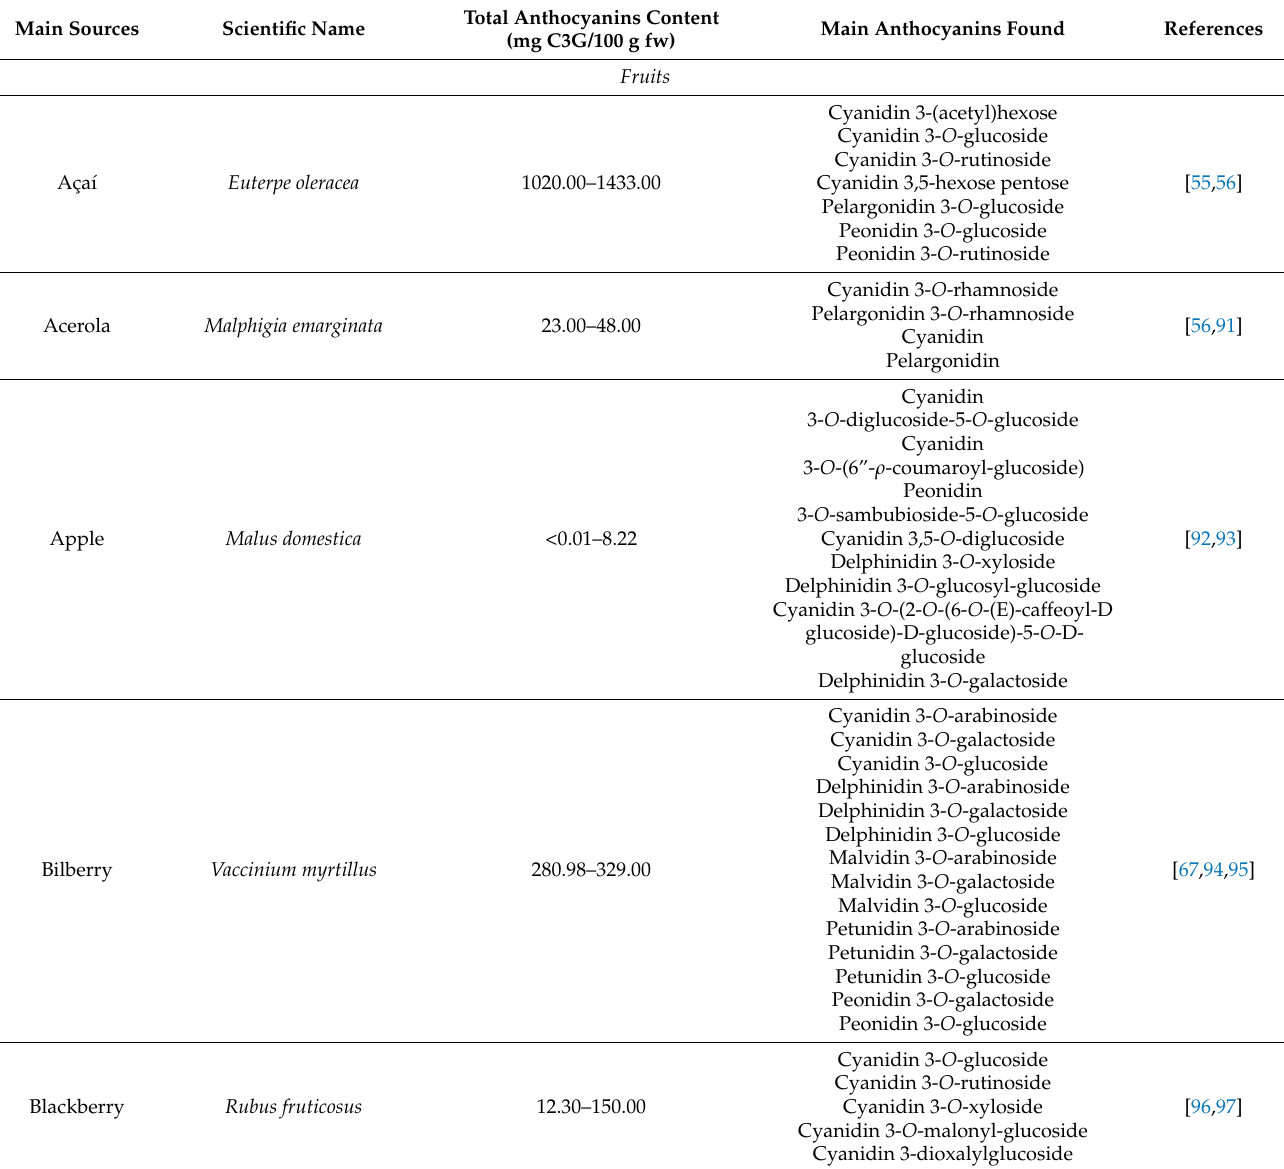
Table 1. Main anthocyanin-rich natural